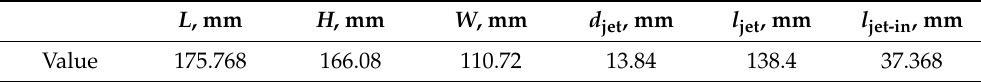
Table 3. Boundary conditions of cross-flow in the mesh sensitivity analysis.